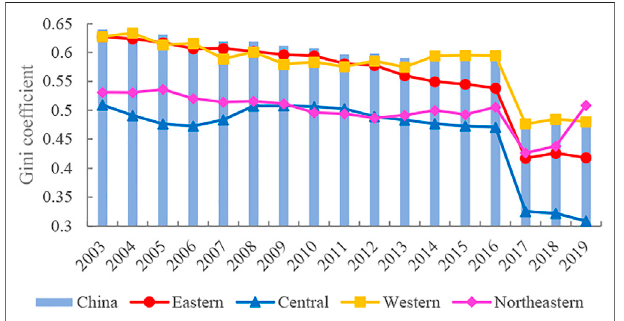
FIGURE 7 | Changing trends of the overall and intra-regional Gini coef fi cient of carbon emission.